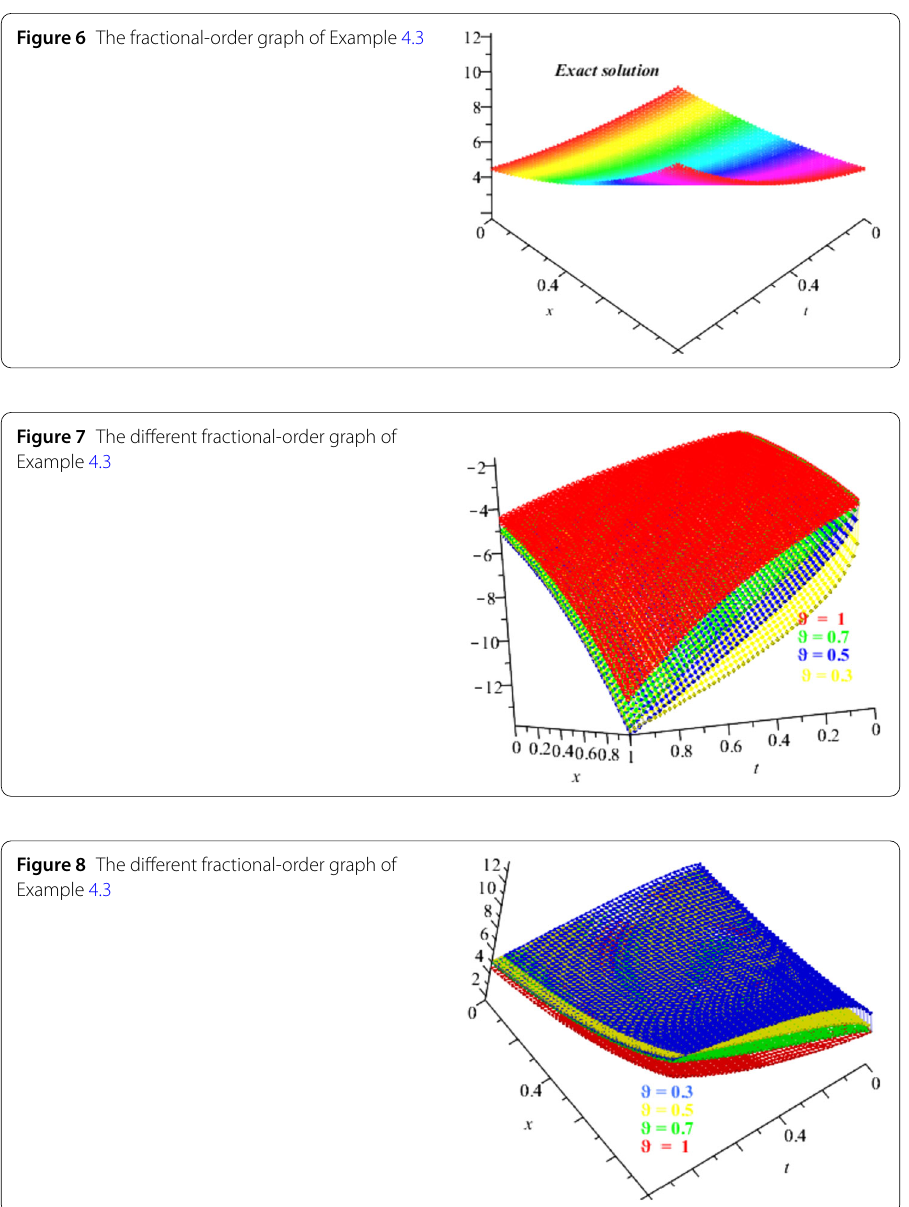
Figure 6 The fractional-order graph of Example 4.3